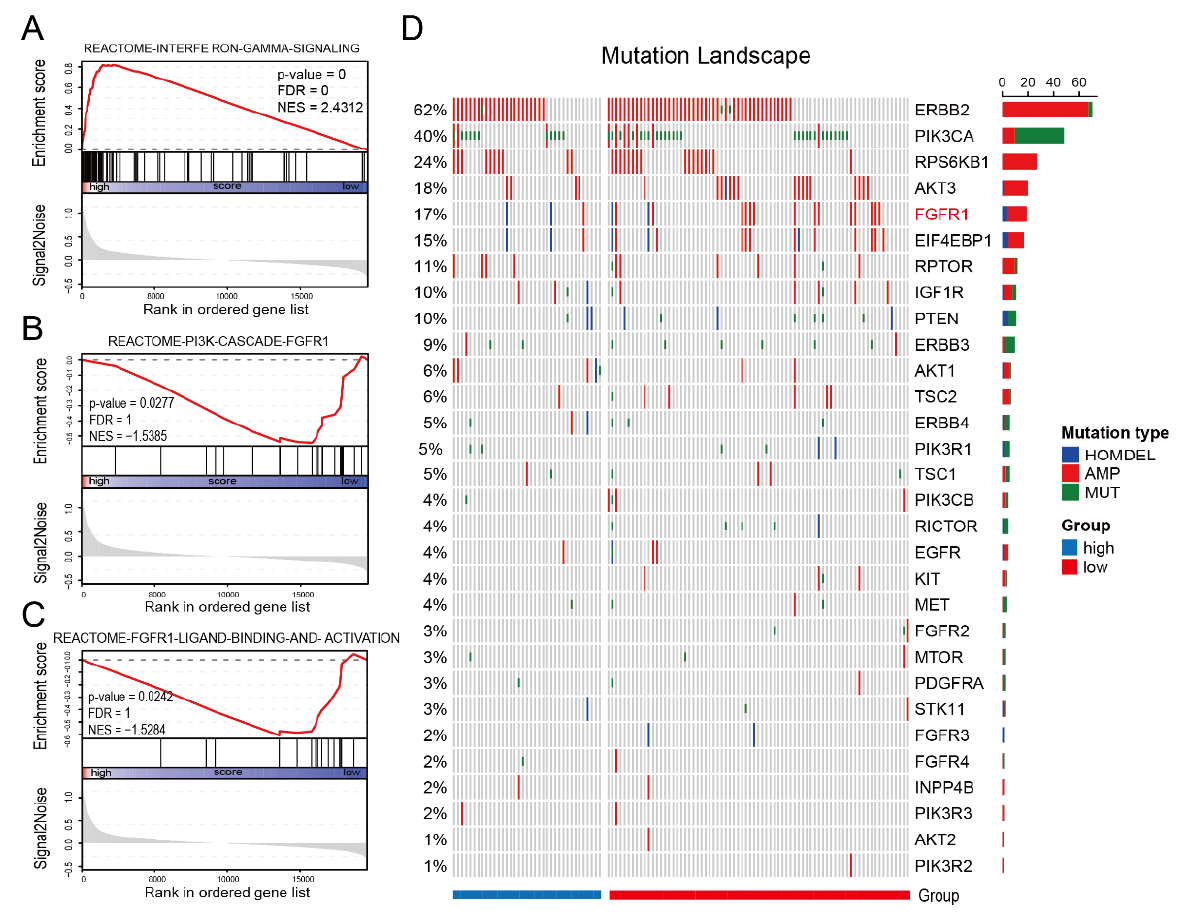
Figure 3. Low-IES status is associated with FGFR1 signaling. Enrichment plots from gene-set enrichment analysis (GSEA) for the interferon-gamma signaling ( A ), PI3K cascade FGFR1 signaling ( B ) and FGFR1 ligand binding and activation signaling ( C ). The red lines indicate normalized enrichment scores (NES) calculated by GSEA. The height of the bars indicates the running GSEA enrichment score. Mutational landscape of PI3K pathway-related genes in the TCGA cohort ( D ). The column and row represent patients and genes, respectively. The patients are displayed in a descending order based on the number of mutated genes. The right panel indicates the frequency of gene mutations. Different colors indicate different types of mutations. Gray denotes no muta- tions. HOMDEL: homozygous deletion; AMP: amplification; MUT: mutation.